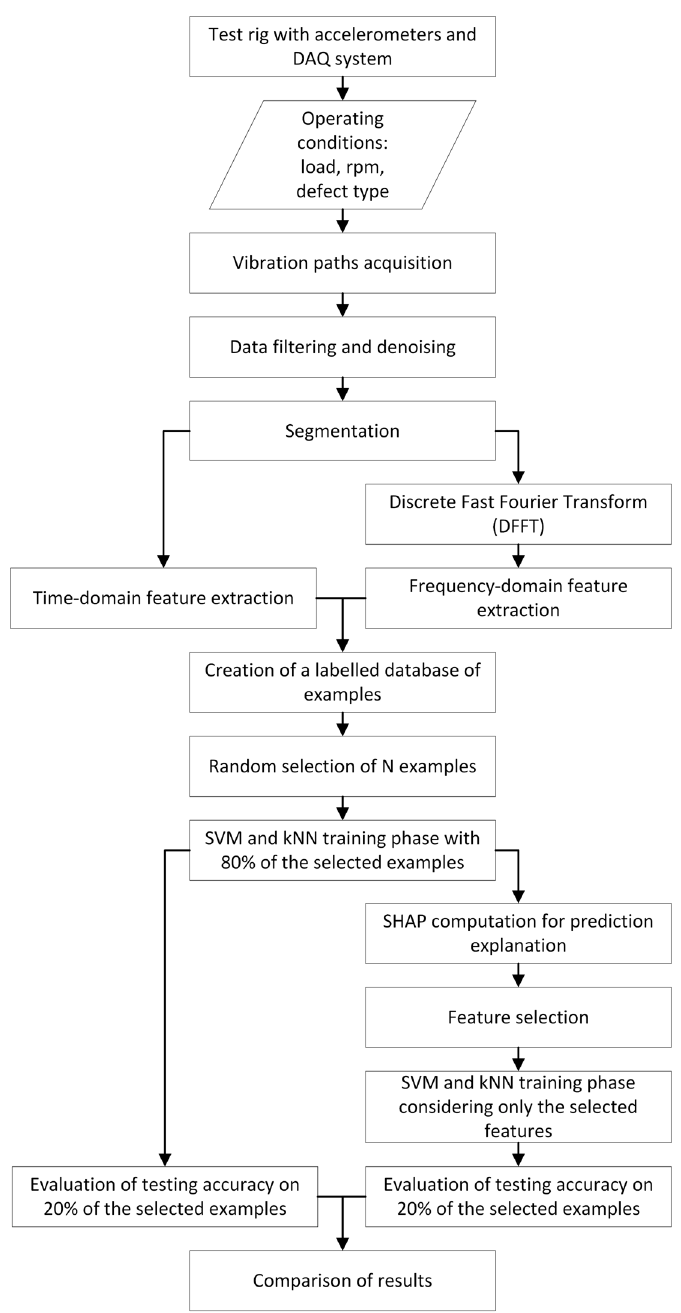
Figure 4. Flowchart of the procedure presented in this